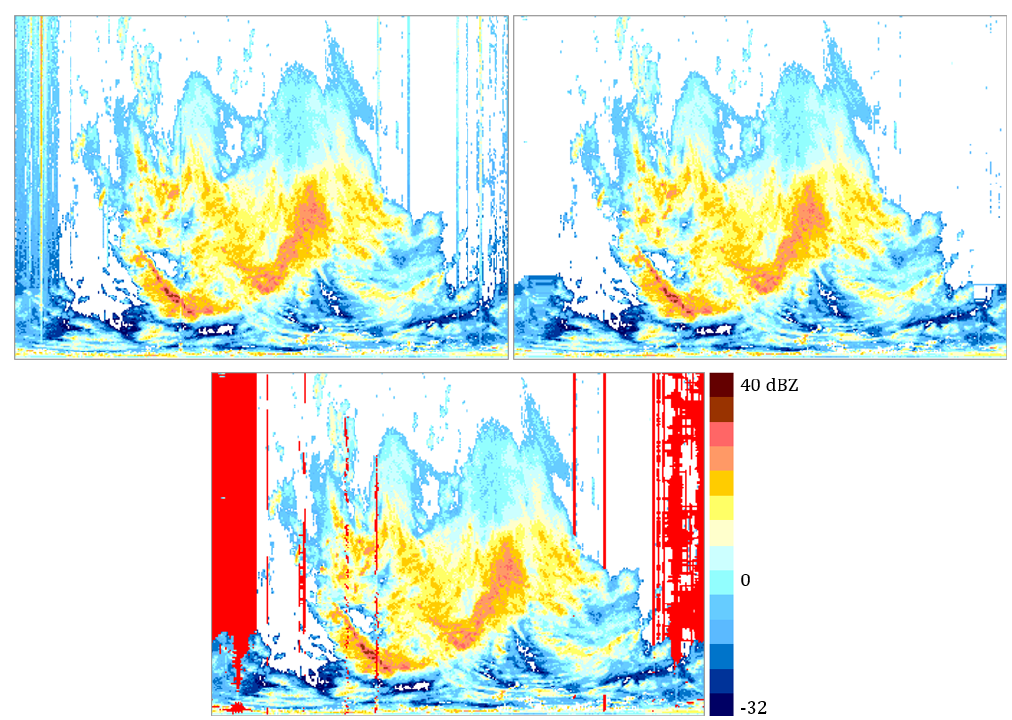
Figure 11. An example of detecting spike echoes with the SPIKE algorithm using sub-algorithms for “wide”, “narrow”, and “inverse” spikes (from the top left): raw and corrected data. The bottom shows a mask (in red) of detected spike echoes. Gda´nsk radar, the lowest elevation, 30 September 2019,